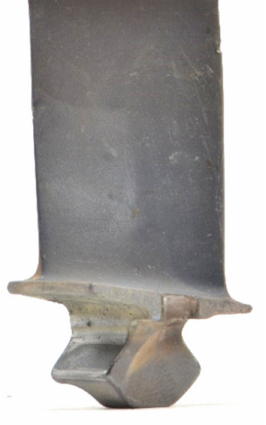
Figure 2. On-bench inspection of a single